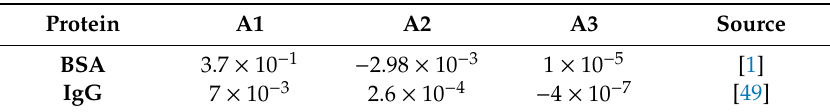
Table 1. Exemplary virial coe ffi cients for the Osmotic pressure of bovine serum albumin (BSA) and immunoglobulin G